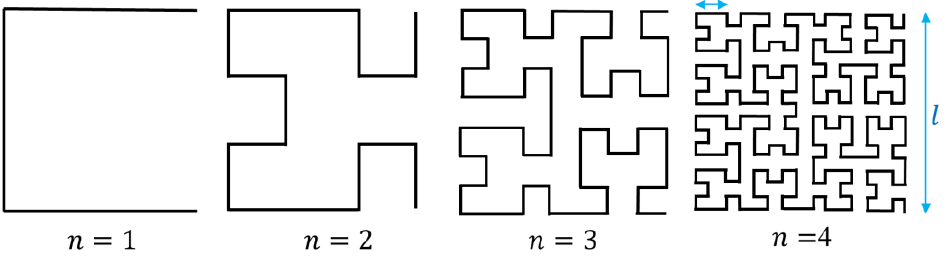
Figure 5. Different orders of Hilbert fractal curves.